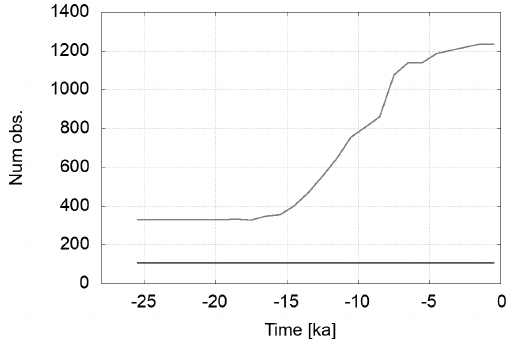
Figure 21. Number of observations in ice-free locations over time. The grey line shows the development of number of observations. The horizontal black line is the number of far-field observations. Far-field observations do not contribute to constraining mantle vis-